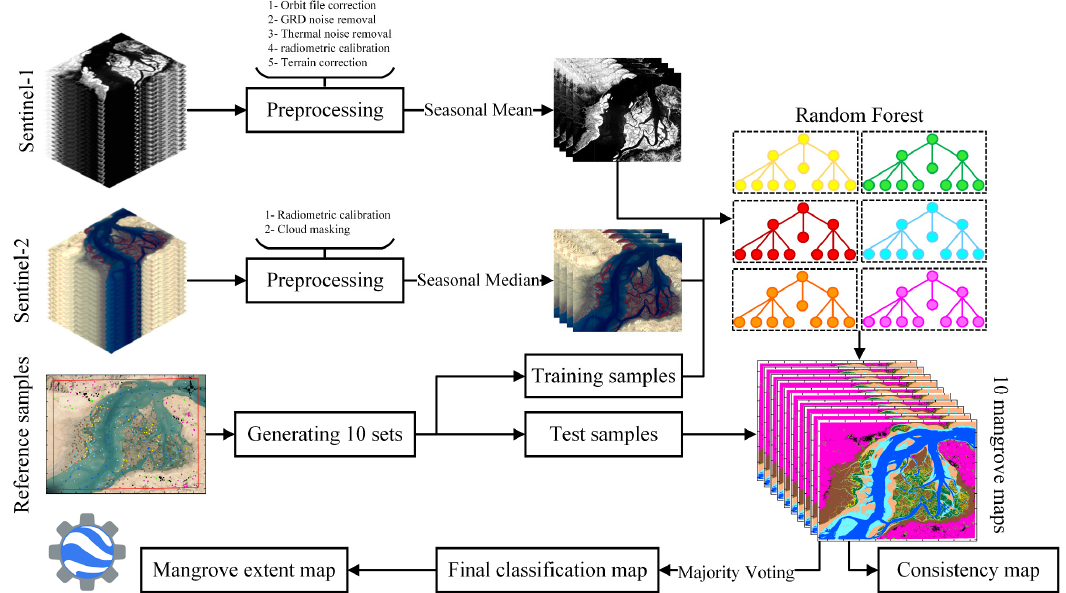
Figure 2. Framework of the proposed method for mangrove ecosystem mapping using the random forest (RF) algorithm and a combination of the Sentinel-1 and Sentinel-2 satellite images within the Google Earth Engine (GEE) platform.